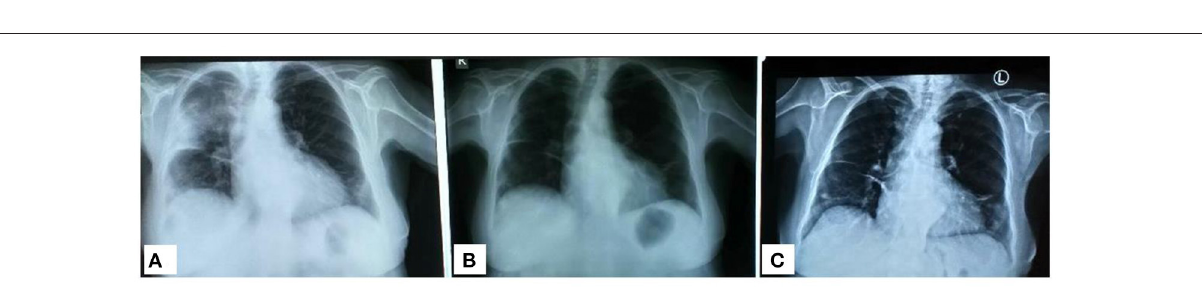
FIGURE 2 | Serial thoracic X-rays that show the migration of the lesions. (A) Image on admission. (B) Picture after corticosteroid initiation as organizing pneumonia. (C) Picture 2 months after